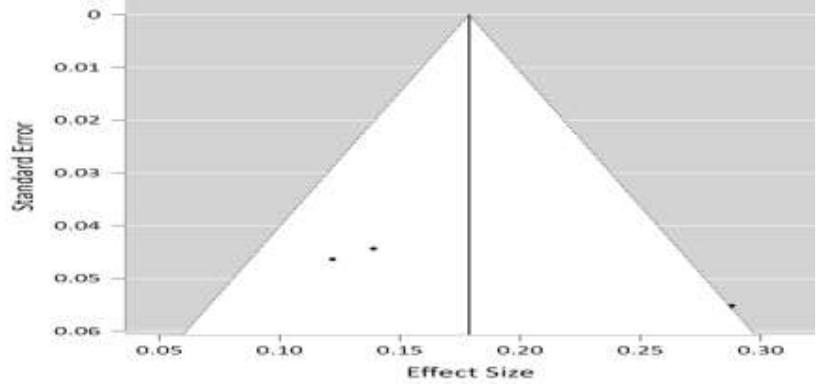
Figure 28. Funnel plot of standard error and effect size of meta-analysis of Identified regulation and Agreeableness